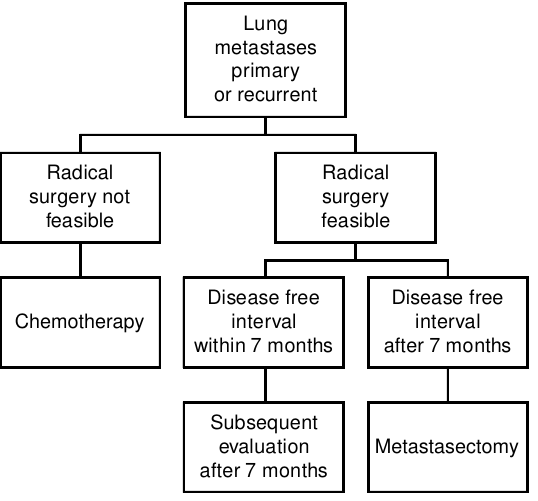
Fig. 1. Algorithm for long metastases from soft tissue